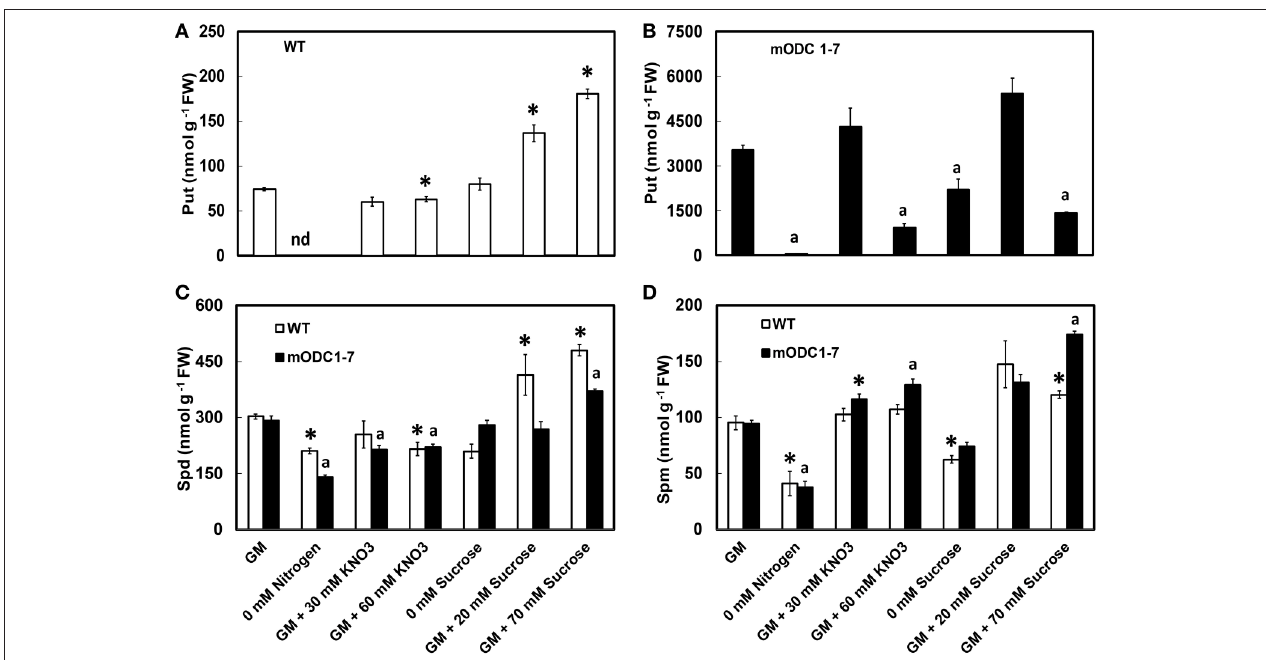
FIGURE 3 | Effects of different concentrations of nitrate and sucrose on PCA soluble polyamines in 12 day old WT and 2x 35S ::m ODC Arabidopsis thaliana seedlings grown on solid GM. Cellular concentrations of (A,B) putrescine, (C) spermidine, and (D) spermine. Data are mean of 4 ± SE; each replicate = 7–8 seedlings. For symbols, see Figure 2